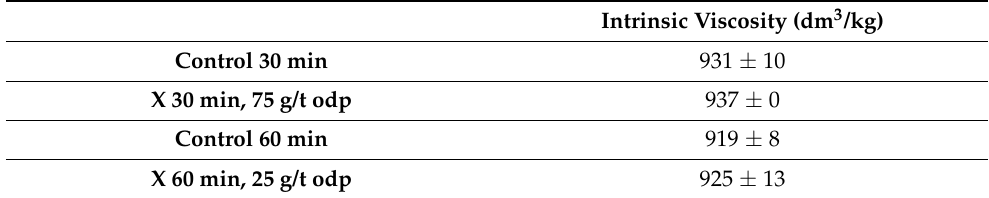
Table 2. Intrinsic viscosity of bleached pulp after complete bleaching of enzyme-treated and untreated oxygen-delignified eucalypt kraft